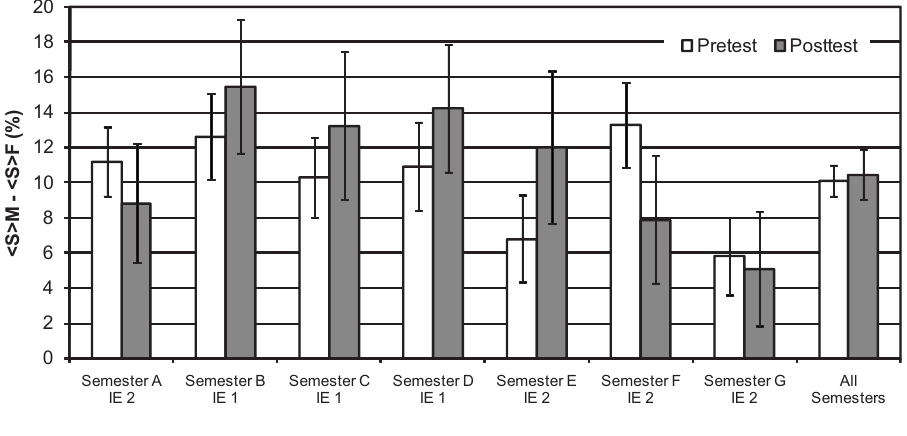
FIG. 2. Gender gaps (cid:1)(cid:5) S (cid:6) M − (cid:5) S (cid:6) F (cid:2) in each semester. IE 1 and IE 2 indicate partially and fully in- teractive courses, respectively. The data represent seven different instructors and over 2000 stu- dents. Error bars represent the standard errors of the